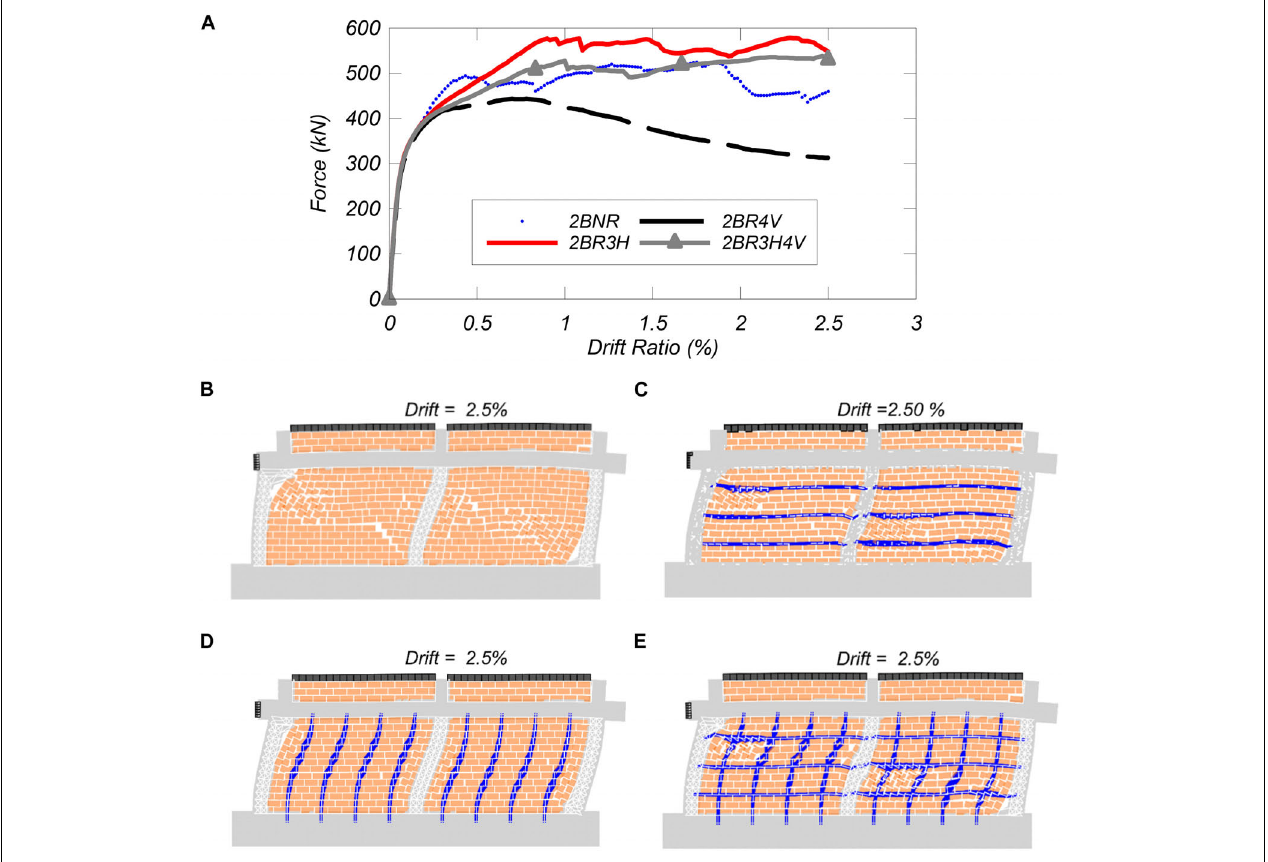
FIGURE 14 | Response of two-bay frame: (A) lateral force vs. drift ratio for two bay frame, deformed shapes at 2.5 percent drift ratio for: (B) 2BNR, (C) 2BR3H, (D) 2BR4V, and (E) 2BR3H4V. TABLE 4 | Numerical results of two-bay frame models. Two-bay models Yield